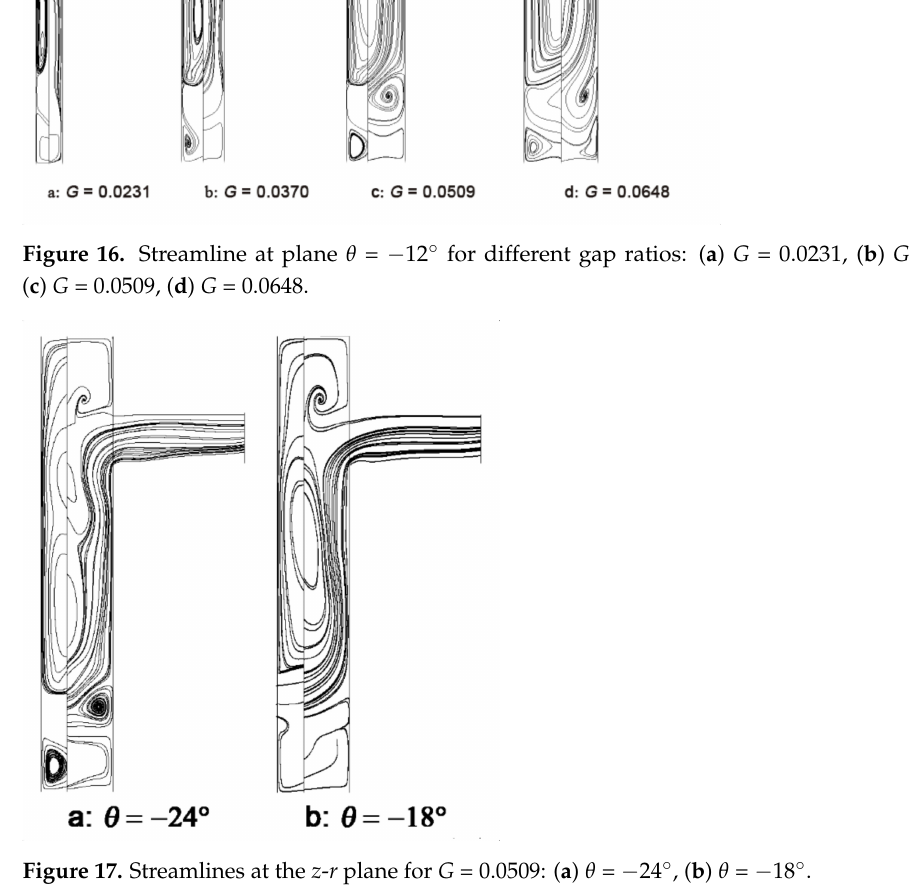
Figure 17. Streamlines at the z - r plane for G = 0.0509: ( a ) θ = − 24 ◦ , ( b ) θ = − 18 ◦